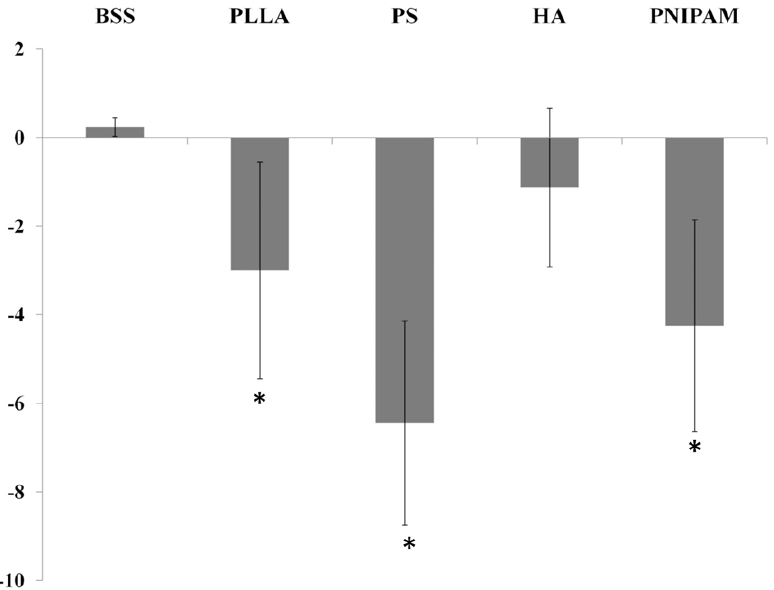
Figure 1. Assessment of mean intraocular pressure variations after administration of particles made of poly-L lactic acid (PLLA), polystyrene (PS), hyaluronic acid (HA), and poly N-isopropyl acrylamide (PNIPAM) and Balanced Salt Solution (BSS) in the vitreous. Data are mean 6 standard deviation. Significance of PLLA, PS, HA, PNIPAM vs. BSS control; * p , 0.05. doi:10.1371/journal.pone.0028720.g001 PLoS ONE |